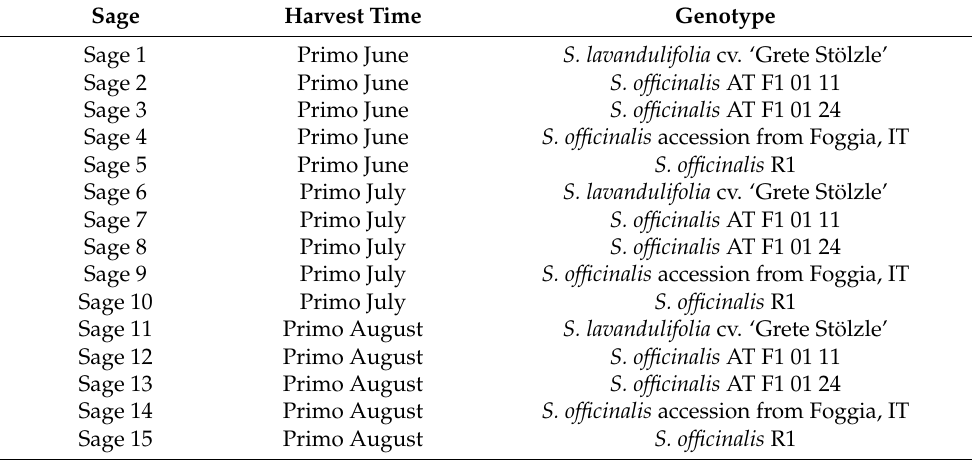
Table 1. Harvest time and genotype of the 15 sage samples investigated for antioxidant capacity. Sage Harvest Time